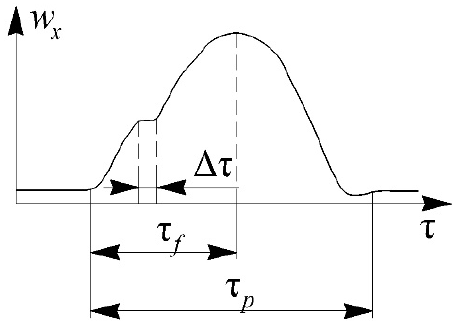
Figure 5. Assumed form of the curve of the air flow velocity pulsation in the gas exchange system of a reciprocating engine (simulation data): τ p —time of one pulsation; τ f —front time; Δτ —air flow fluctuation time.